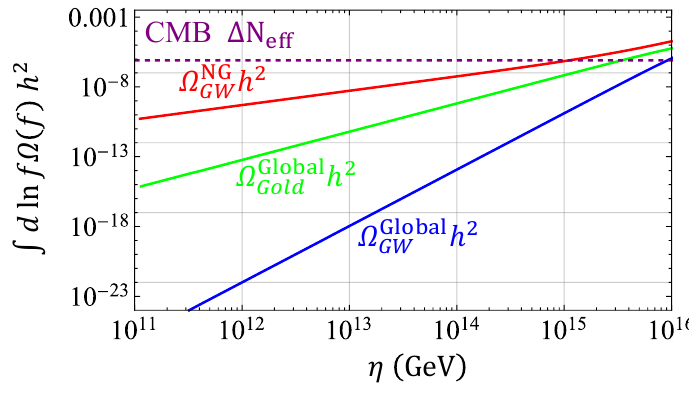
Figure 5 . The total relic densities (integrated over f ) of GWs from a NG string network (red), of GWs from a global string network (blue), and of massless radiation-like Goldstone bosons from a global string network (green), as functions of the symmetry breaking scale η (related to the string tension µ ). The purple dashed line shows the constraint on extra radiation energy density by CMB data: ∆ N . 0 . 2 [130] or R d ( ln f )∆Ω 2 . 8 . 1 × 10 − 7 [130, 131], which requires rad h eff η . 3 . 5 × 10 15